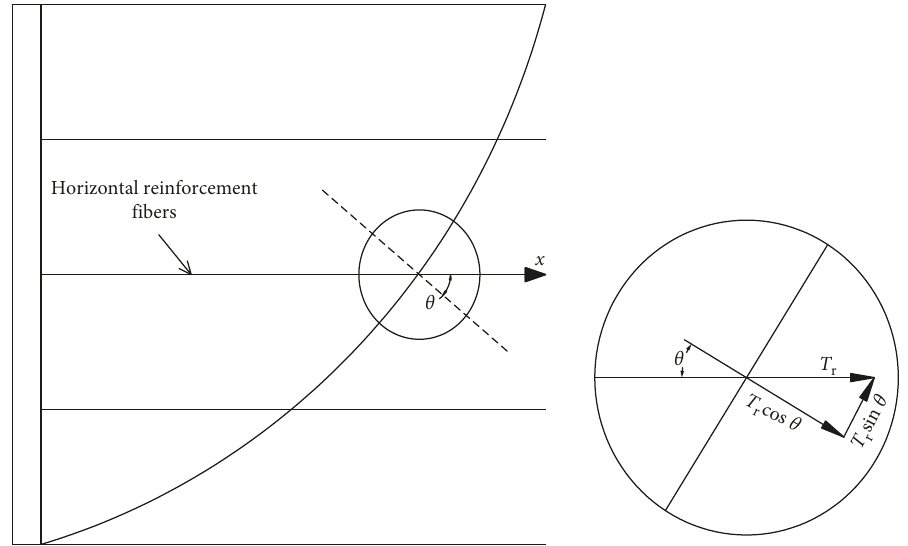
Figure 11: Schematic diagram of the horizontal reinforcement.